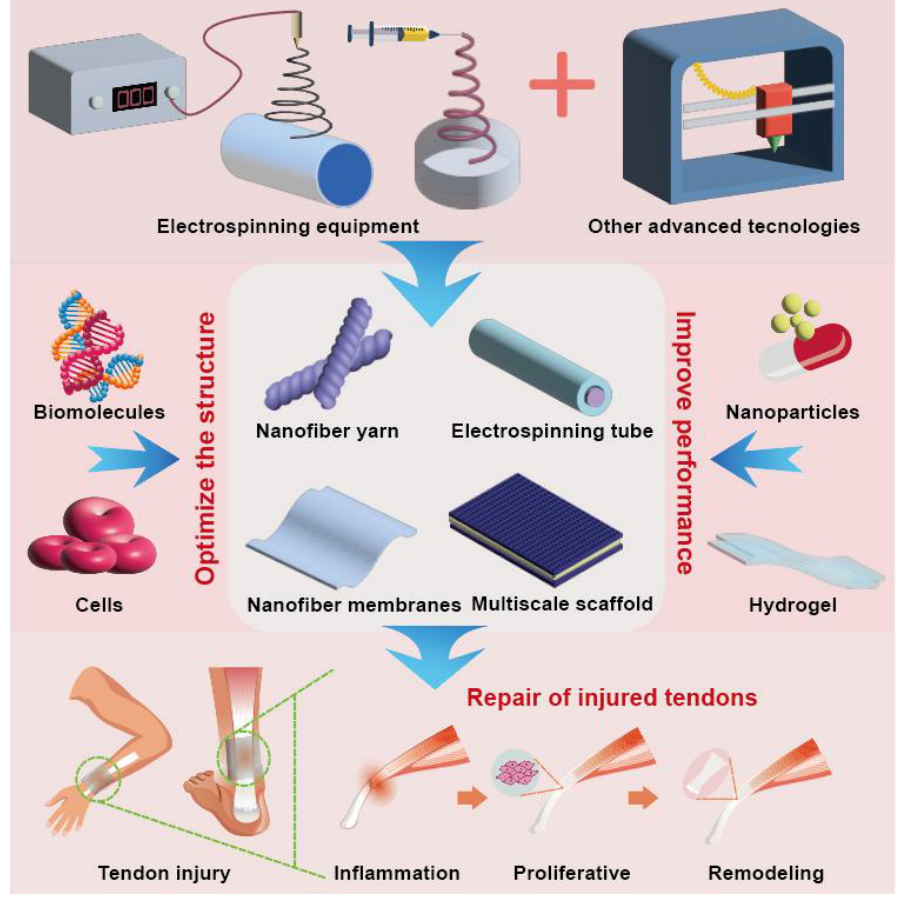
Figure 1. Diagram of electrospinning technology and its applications in the biomedical field.